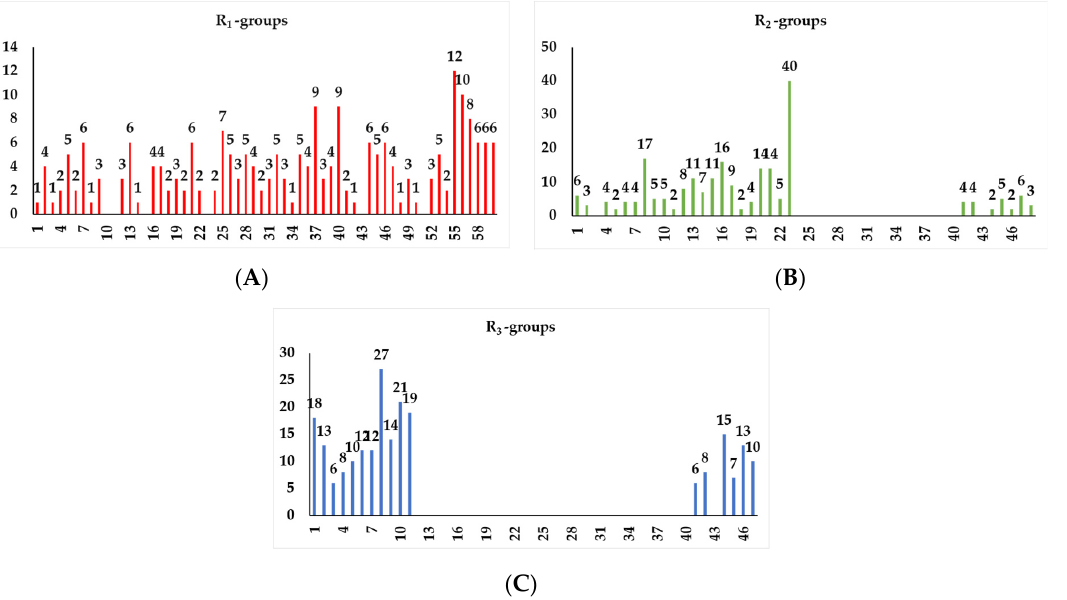
of the cofactor nicotinamide adenine dinucleotide. The cationic substituents in the partially solvent-exposed R 3 -position caused stabilization of the bound TCL analogues by the effect of hydration. These substitutions led to an overall predicted increase in the binding affinity of the new TCL analogues to Pf ENR. The best TCL analogues TCL-60 - 08 - 08 and TCL-33 - 08 - 05 (Figure 7) show predicted half-maximum inhibitory concentrations of (IC pre = 1.9 nM and 50 IC pre = 4.1 nM), i.e., could be almost 20 times more potent than the most active compound in 50 = 38nM). Molecular mechanics refinement of the 219 the training set, namely TCL15 (IC exp 50 top-ranking TCL analogues and prediction of the half-maximal inhibitory concentrations by means of computed rGFE of the ligands led to the identification of potent virtual hits with chemical structures that reach beyond the requirements of the PH4 pharmacophore model, especially in the R 2 - and R 3 -positions where hydrophobic interactions were expected.